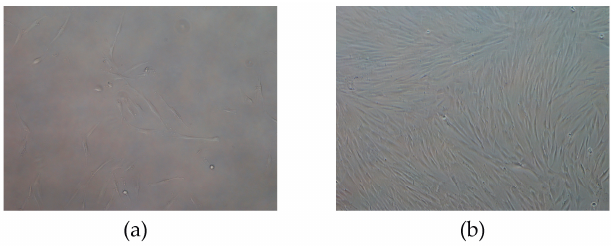
Figure 8. ( a ) Cells after 24 h of culture (original magnification × 100). ( b ) Cells at confluence after 1 week of culture (original magnification × 100).